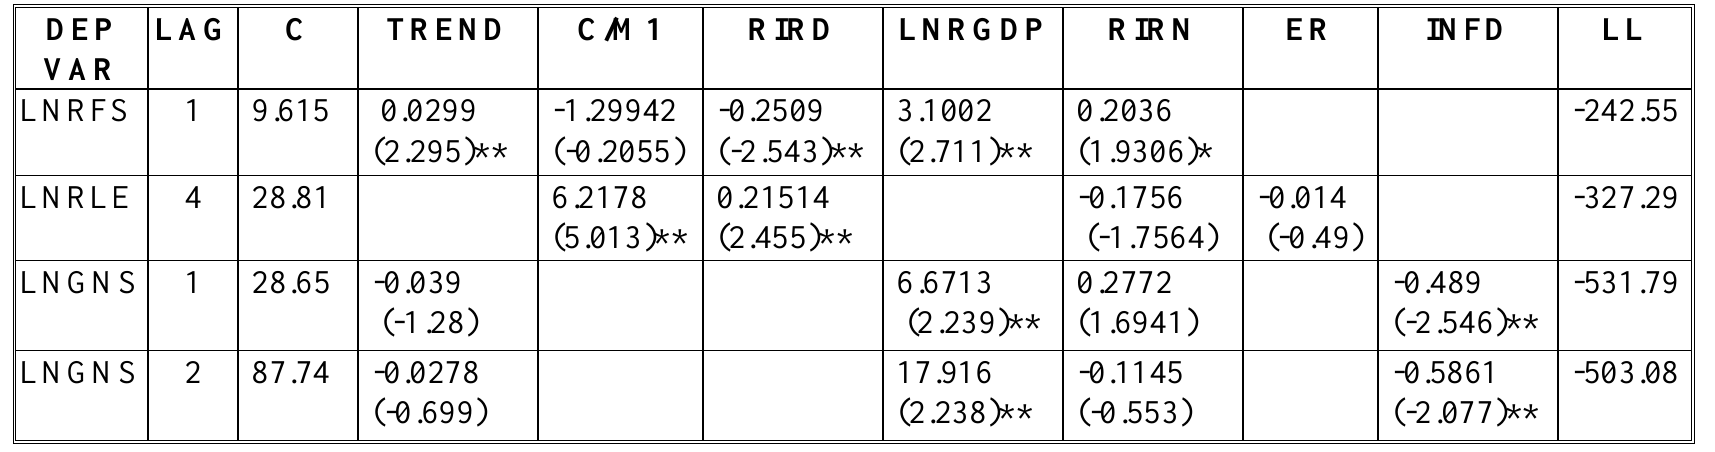
Cointegration regressions: LNRSTFS; LNRLE; &